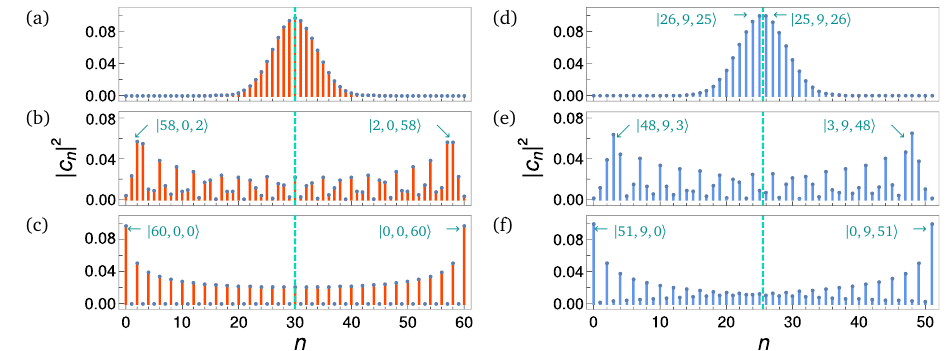
Figure 10: Fock state probabilities. Results shown for t = T / 4 and N = 60. The index | 2 denotes the probability associated n labels the Fock state | N − l − n , l , n 〉 , and | c n to it. Left panels: U = 0.17 and l = 0 for initial states (a) : | 60,0,0 〉 , (b) : | 40,0,20 〉 and (c) : | 30,0,30 〉 . Right panels: U = 0.7 and l = 9 for initial states (d) : | 51,9,0 〉 , (e) : | 36,9,15 〉 and (f) : | 26,9,25 〉 . The vertical dashed lines mark the midpoints of the probability distributions. In the right column, where l = 9, the results display a slight asymmetry with respect to reflections about the